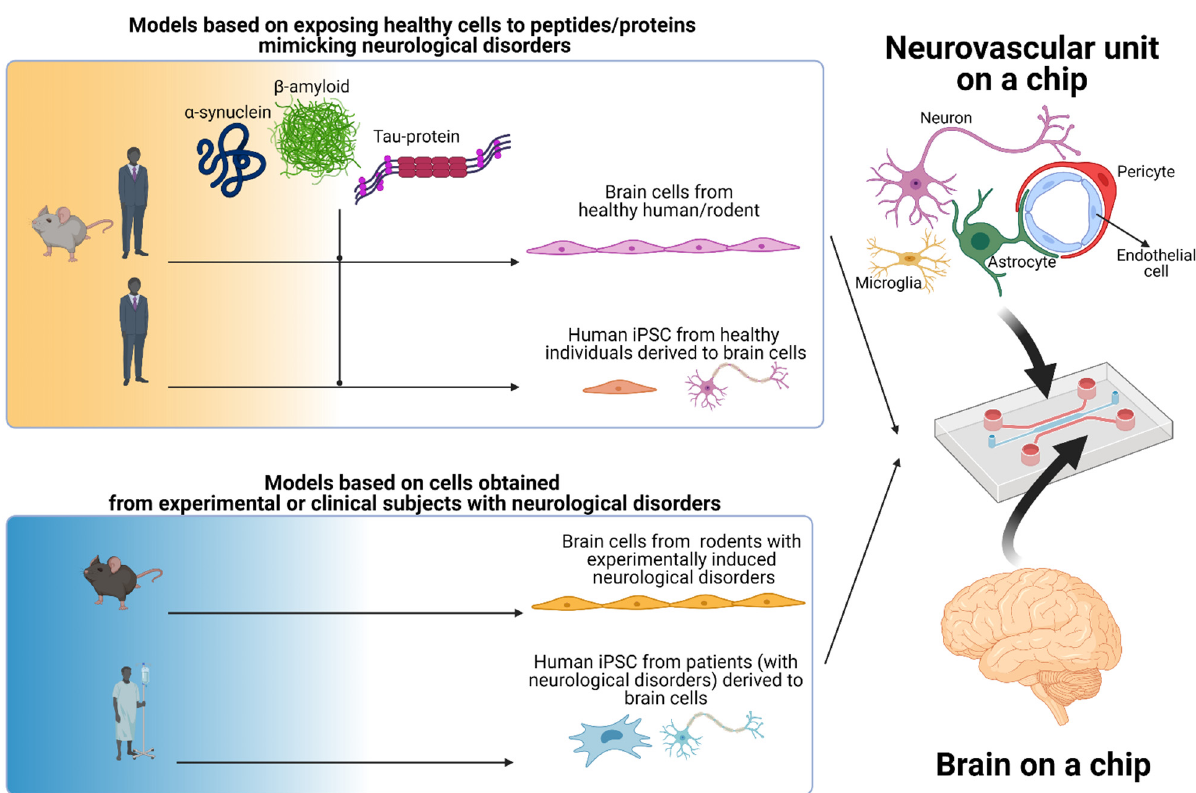
Figure 4. Strategies to mimic neurodegenerative disorders based on the NVU-on-a-chip/brain-on-a-chip technology. The main models developed to mimic neurodegenerative disorders on a chip are (i) testing human/rodent cells from healthy subjects exposed to peptides/proteins (e.g., beta-amyloid, alpha-synuclein, tau-protein), (ii) testing human/rodents cells obtained from experimental or clinical subjects with neurological disorders (generated with BioRender.com [91] ).